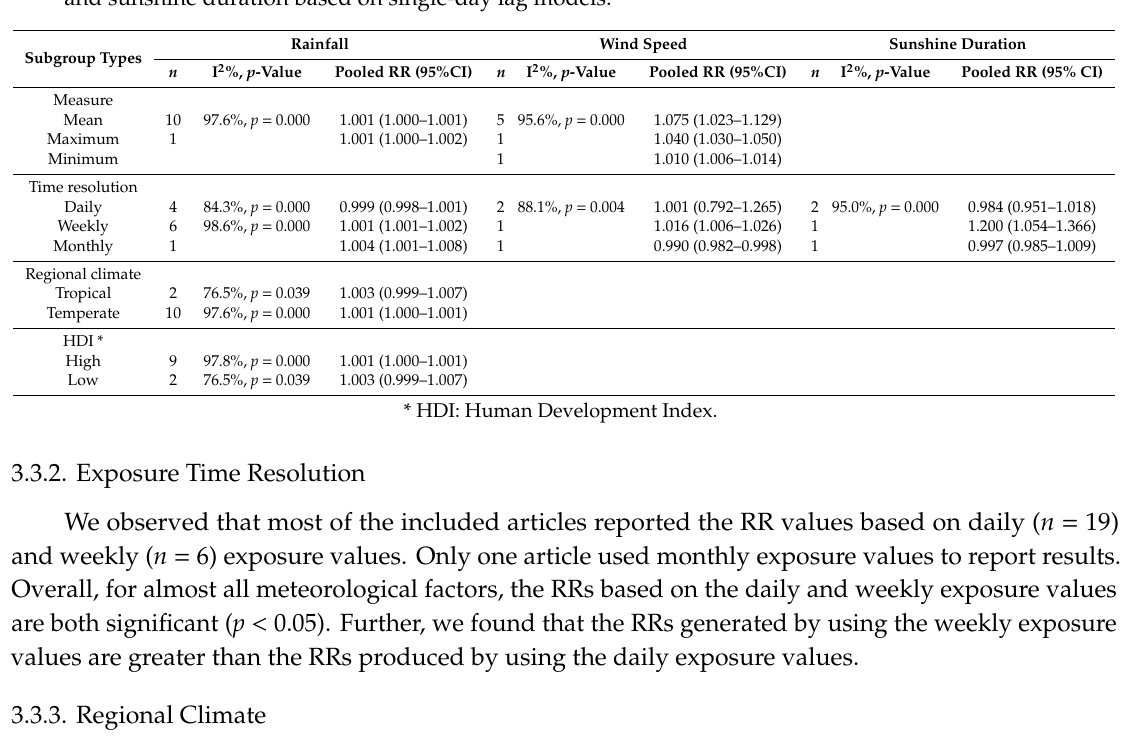
Table 3. Subgroup analysis for the increased HFMD risk associated with rainfall, wind speed, and sunshine duration based on single-day lag